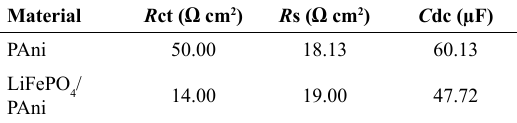
Figure 9. Nyquist diagrams of LiFePO Hz to open circuit potential. High frequency region in Nyquist diagram of LiFePO Table 4. Electrochemical parameters of the PAni and LiFePO